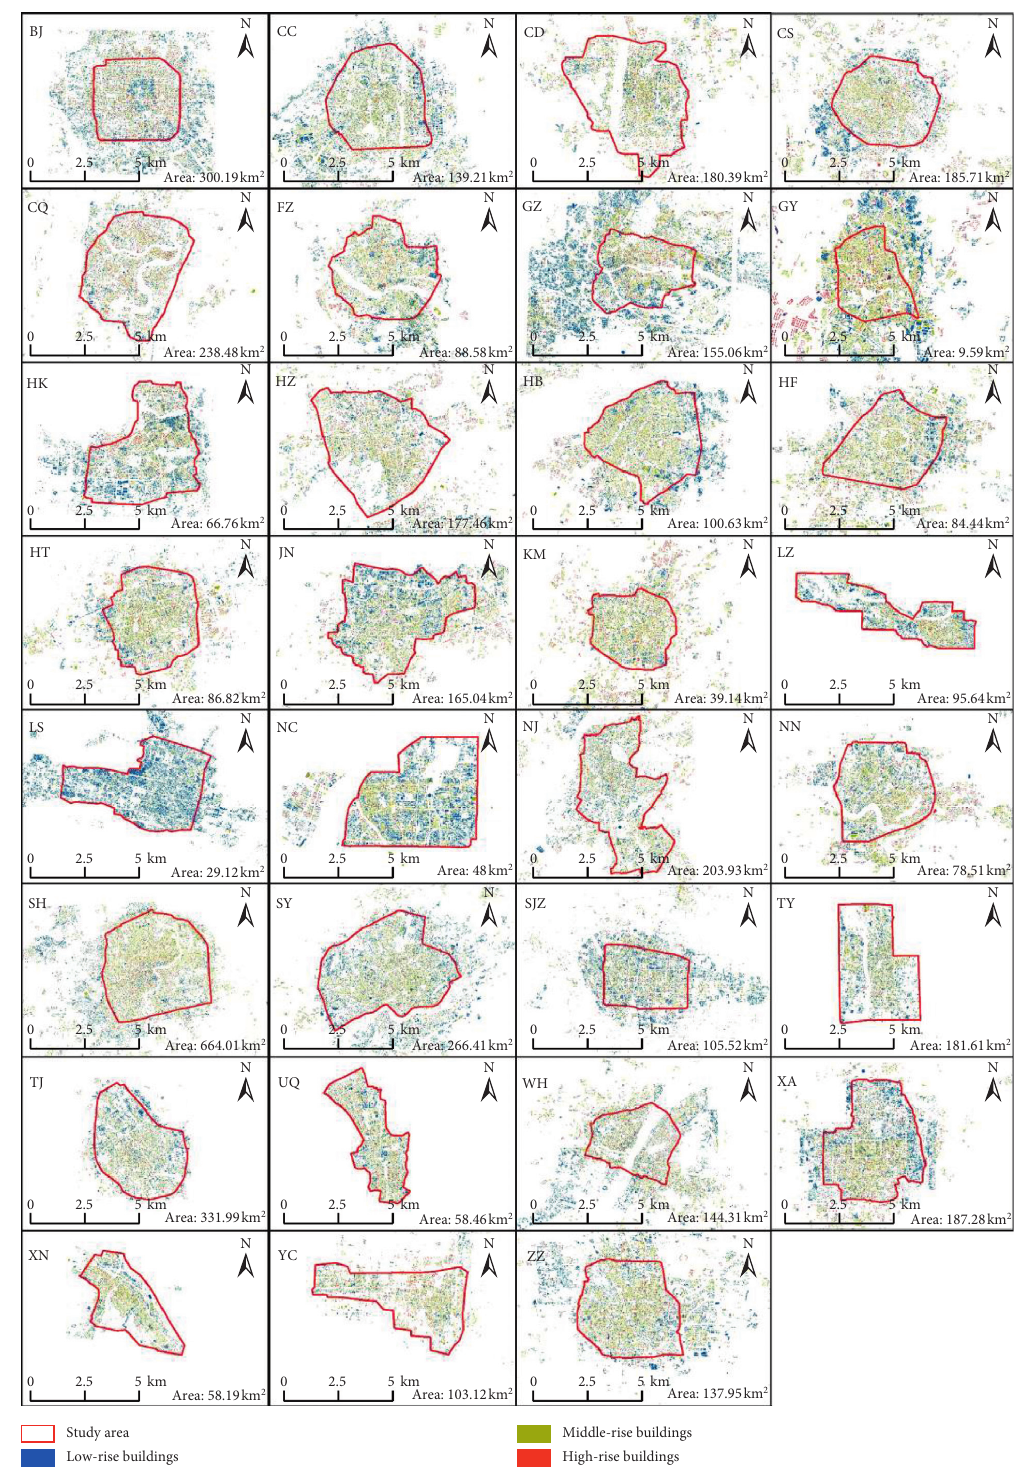
Figure 2: The spatial distribution of urban buildings in provincial cities of mainland